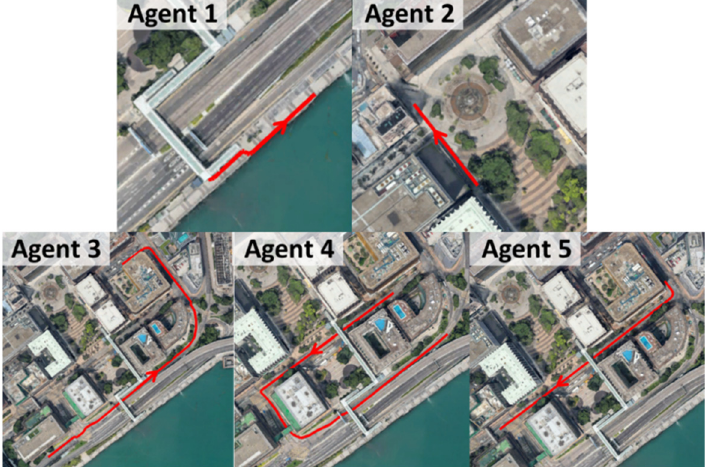
Figure 23. The trajectory of each agent simulated from SUMO [36] for the proposed multiagent GNSS measurement simulation and positioning performance evaluation. Agents 1 and 2 are simulated as pedestrians while Agents 3–5 are simulated as vehicles. The arrow on the trajectory denotes the moving direction.